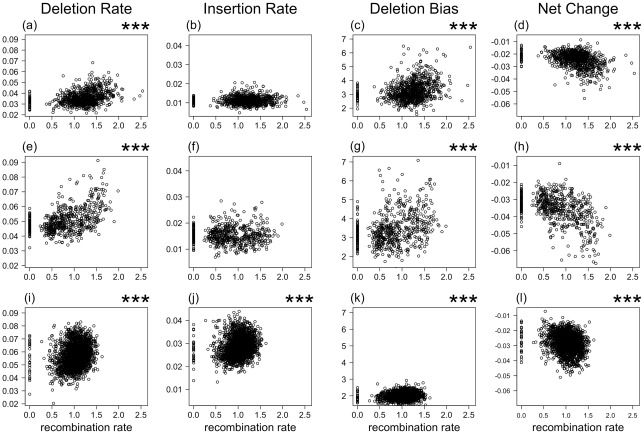
The relationship between recombination rate (x-axis, fourth-root) and deletion rate, insertion rate, deletion bias (deletion rate/insertion rate), and rate of net sequence length change (insertion rate – deletion rate).In chicken (a, b, c, and d), zebra finch (e, f, g, and h), and human (i, j, k, and l). p<0.001 in Kendall's rank correlation test is depicted by ***.